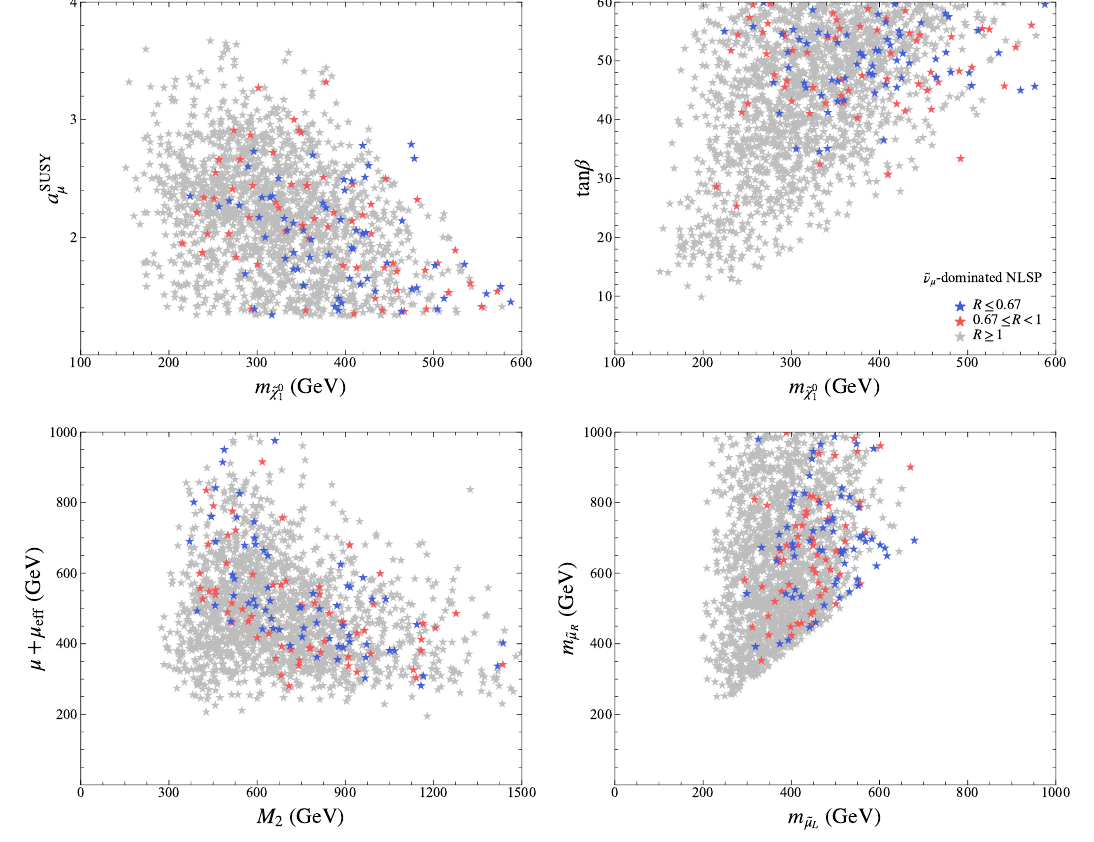
Figure 4 . The LHC constraints on the samples with ˜ ν µ -dominated NLSP. The samples are projected on m , m − a SUSY − tan β , M 2 − ( µ + µ eff ) and m ˜ µ ˜ χ 0 1 ˜ χ 0 1 µ R ≥ 1 , 0 . 67 ≤ R < 1 and R < 0 . 67 are marked by grey, red, and blue colors, respectively.